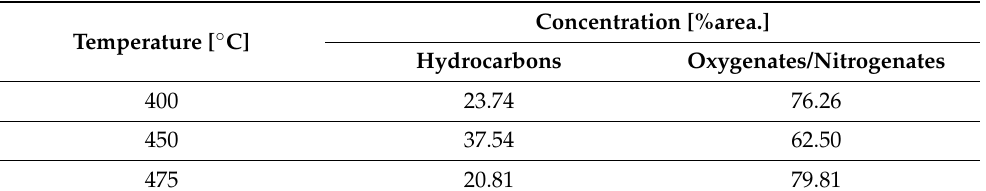
Table 13. Effect of temperature on the chemical composition, expressed as hydrocarbons and oxy- genates/nitrogenates, of bio-oils obtained by pyrolysis of MHSW fraction (organic matter + paper) at 400, 450, and 475 ◦ C, 1.0 atm, in laboratory scale. Concentration [%area.] Temperature [ ◦ C]